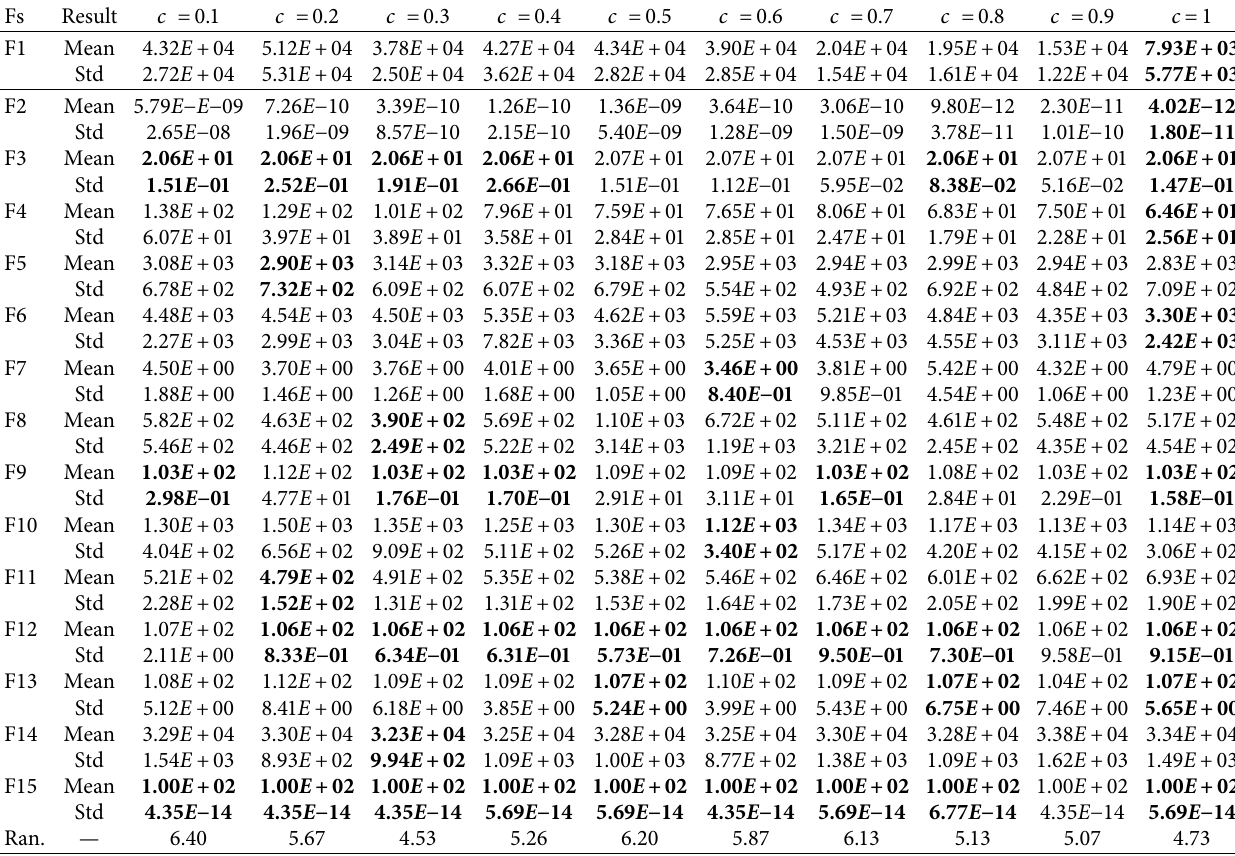
Table 4: Results of solution accuracy obtained by ASDE with different c value on 15 benchmark functions of CEC2015.